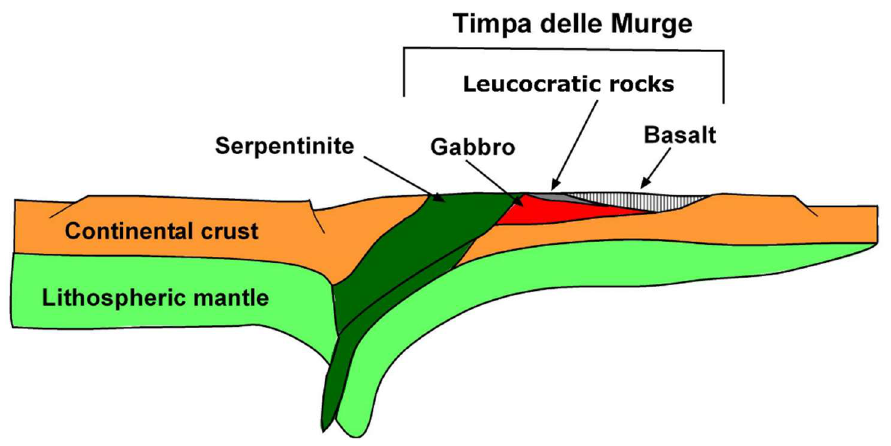
Figure 14. Schematic illustration showing the tectonic setting regarding the formation of the leuco- cratic rocks in the Pollino Massif.